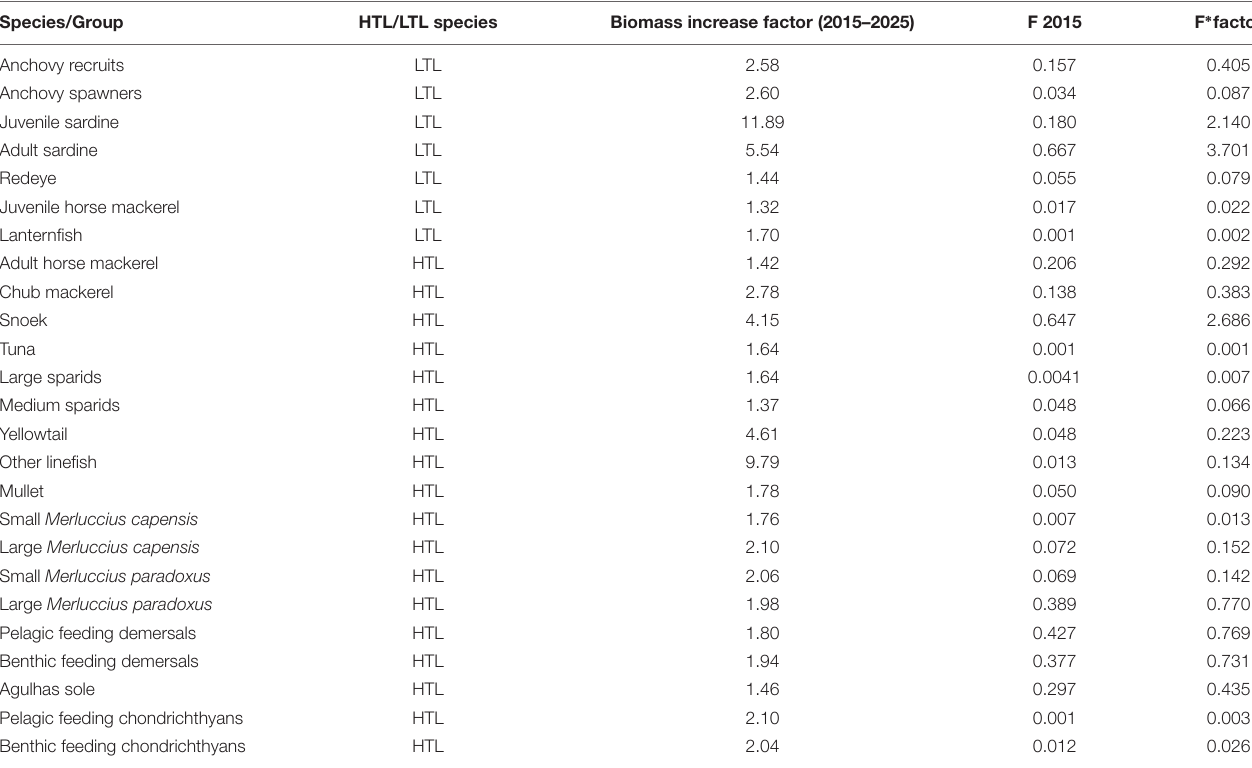
TABLE 1 | Details on the species for which fishing pressure was increased in the various scenarios. Species/Group HTL/LTL